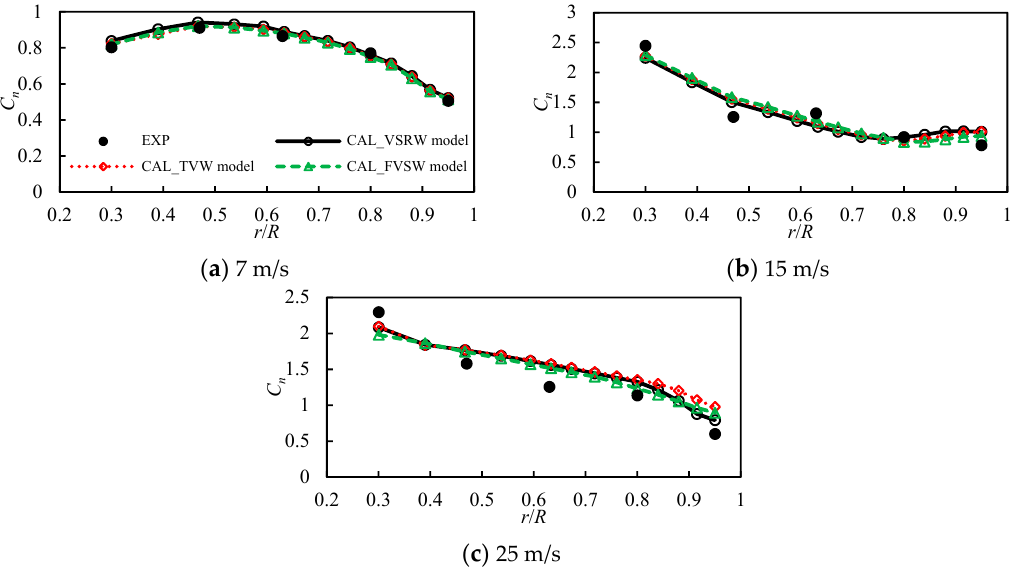
Figure 11. Measured and calculated results of LSST of NREL Phase VI wind turbine for wind speeds ranging from 7 m/s to 25 m/s.